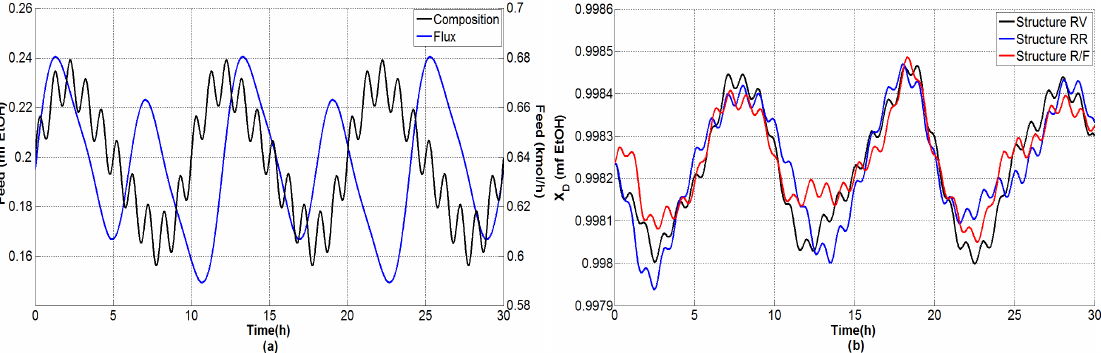
Figure 17. ( a ) continuous fluctuating perturbation of the feed flux rate and feed molar fraction composition and ( b ) performance of the structures under oscillating simultaneous